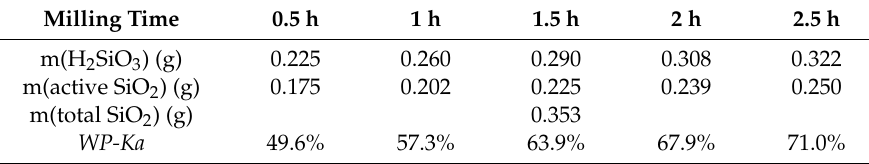
Table 9. Percentage of active SiO 2 of